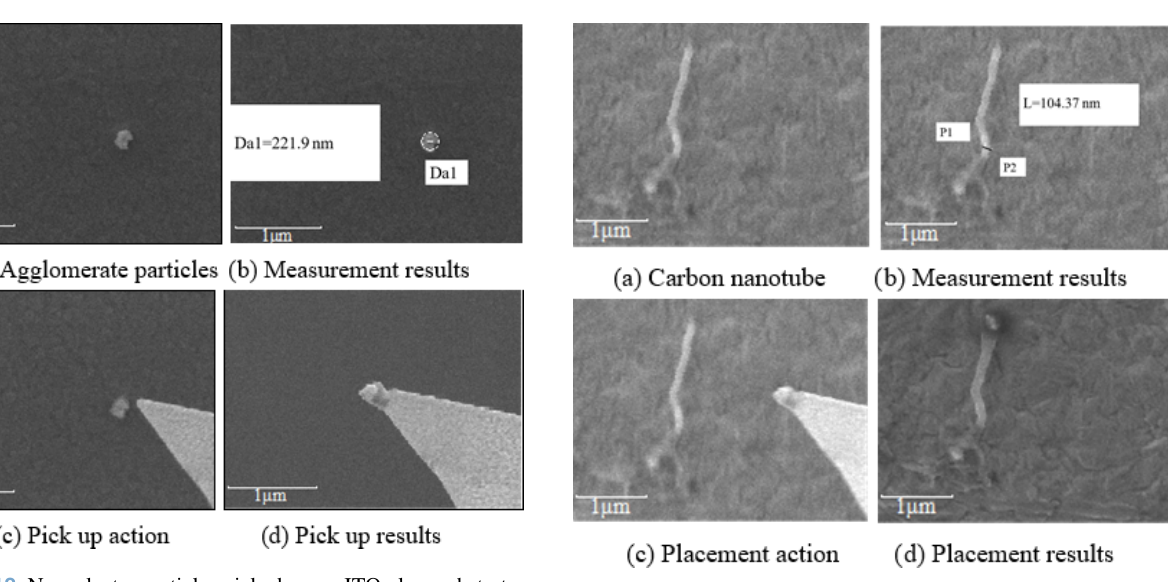
Figure 13. Construction of carbon nanotube–nanocluster cluster structure at electrode substrate in three